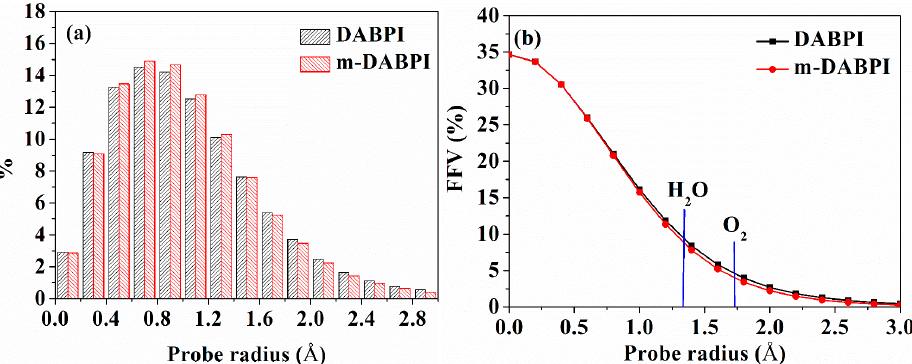
Figure 7. Distributions of void radii ( a ) and fractional free volume ( b ) as a function of probe radius in DABPI and m-DABPI. The kinetic radii of O 2 and H 2 O are indicated by vertical lines.